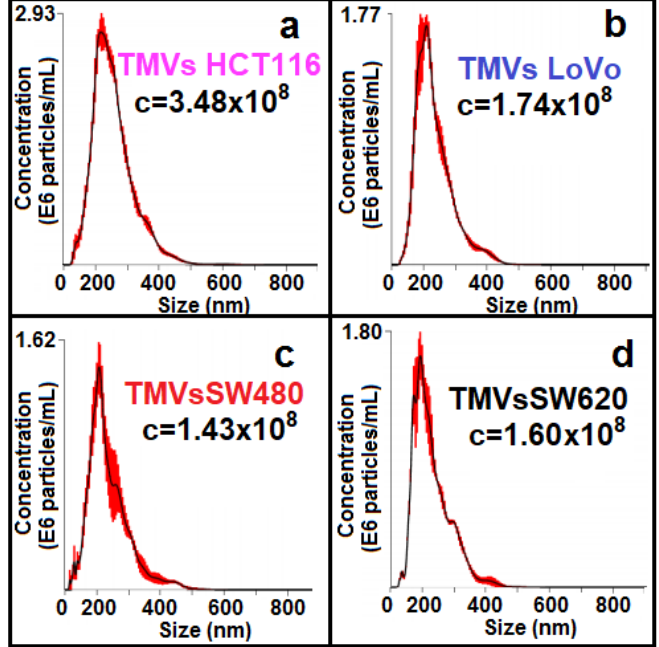
Figure 2. Nanoparticle tracking analysis of size distribution and concentrations (number EVs / mL) of TMVs collected from HCT116 ( a ), LoVo ( b ), SW480 ( c ), and SW620 ( d ) cell lines.